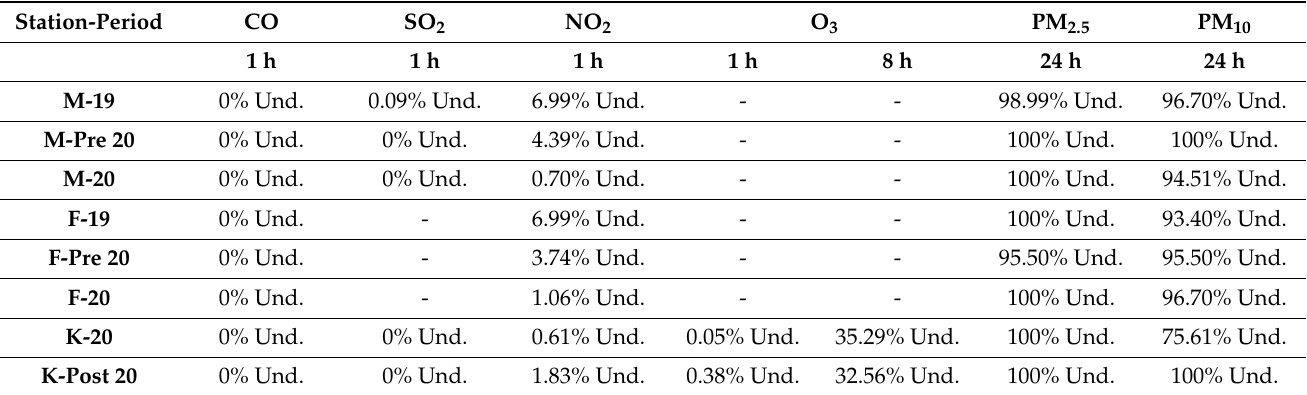
Table 1. Percentage of undesirable air (moderate, unhealthy for sensitive groups, unhealthy, very unhealthy, and hazardous) as indicated by AQIs for individual pollutants during the corresponding